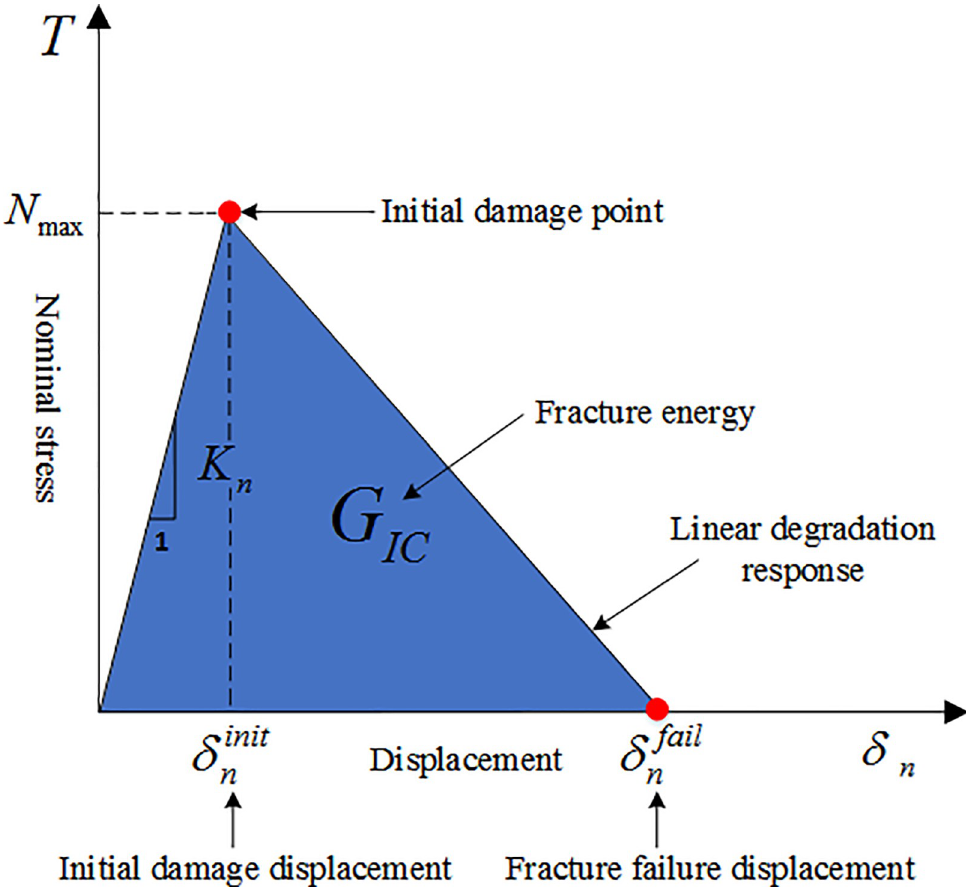
Fig 1. Cohesive unit traction separation